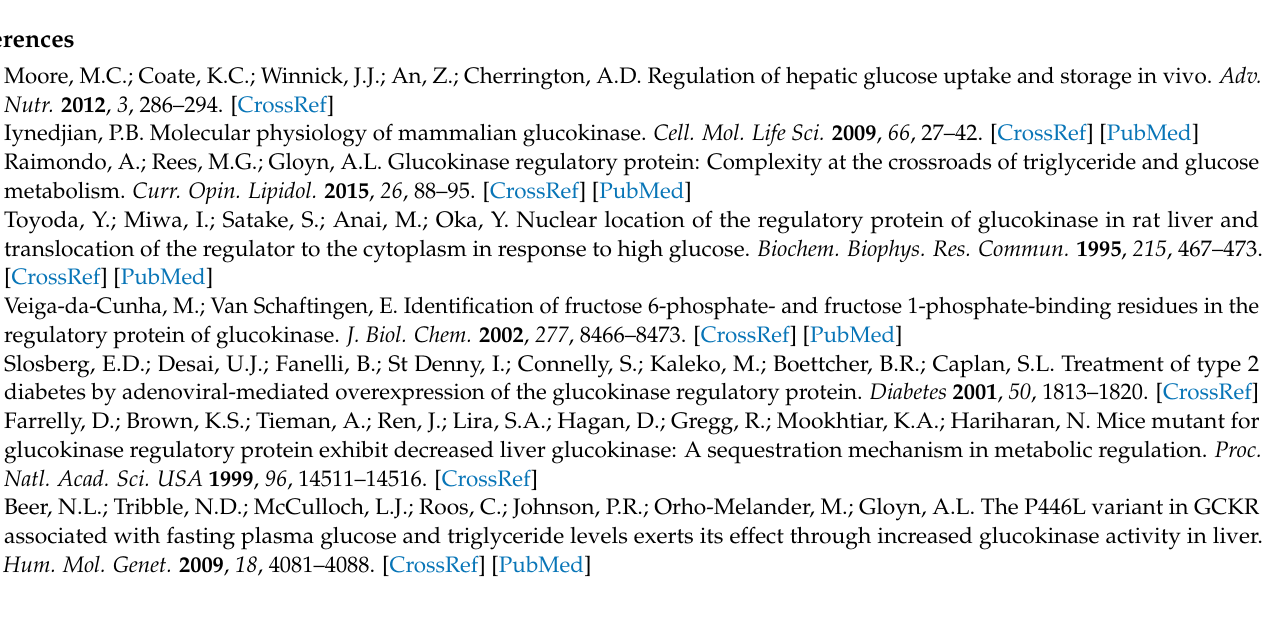
Figure S13: Regional plot association studies genetic variants at positions 27.62 to 27.85 mega-base on chromosome 2p23.3 for ALT without (A) or with (B) conditional analysis; Figure S14: Regional plot association studies genetic variants at positions 27.62 to 27.85 mega-base on chromosome 2p23.3 for serum γ GT level without (A) or with (B) conditional analysis; Figure S15: Regional plot association studies genetic variants at positions 27.62 to 27.85 mega-base on chromosome 2p23.3 for leukocyte count without (A) or with (B) conditional analysis; Figure S16: Regional plot association studies genetic variants at positions 27.62 to 27.85 mega-base on chromosome 2p23.3 for platelet count without (A) or with (B) conditional analysis; Figure S17: Regional plot association studies genetic variants at positions 27.62 to 27.85 mega-base on chromosome 2p23.3 for the risk of hypertension without (A) or with (B) conditional analysis; Figure S18: Regional plot association studies genetic variants at positions 27.62 to 27.85 mega-base on chromosome 2p23.3 for the risk of gout without (A) or with (B) conditional analysis; Figure S19: Regional plot association studies genetic variants at positions 27.62 to 27.85 mega-base on chromosome 2p23.3 for the risk of microalbuminuria with-out (A) or with (B) conditional analysis; Figure S20: Regional plot association studies genetic variants at positions 27.62 to 27.85 mega-base on chromosome 2p23.3 for the risk of metabolic syndrome without (A) or with (B) conditional analysis; Figure S21: Linkage disequilibrium map of GCKR gene region rare